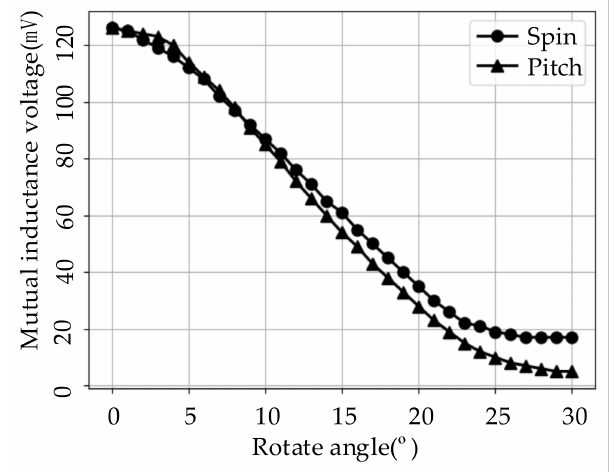
Figure 8. Mutual inductance voltage measurements for yaw and pitch motion in the 30 ◦ range of the layer coil.